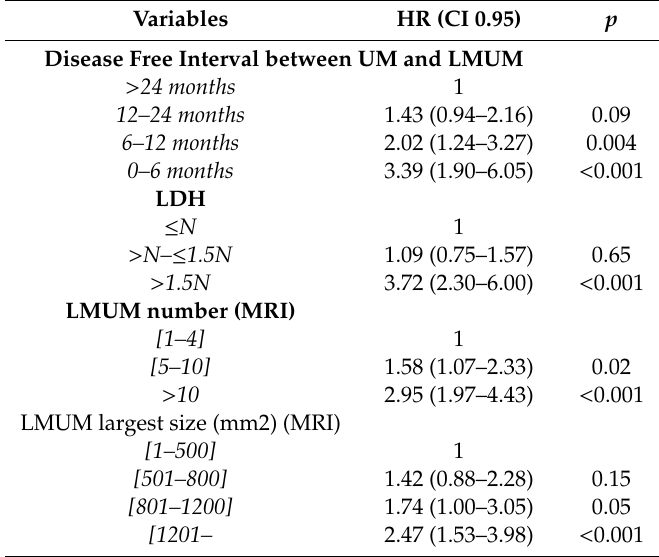
Table 2. Multivariable analysis of factors associated with overall survival after diagnosis of LMUM.